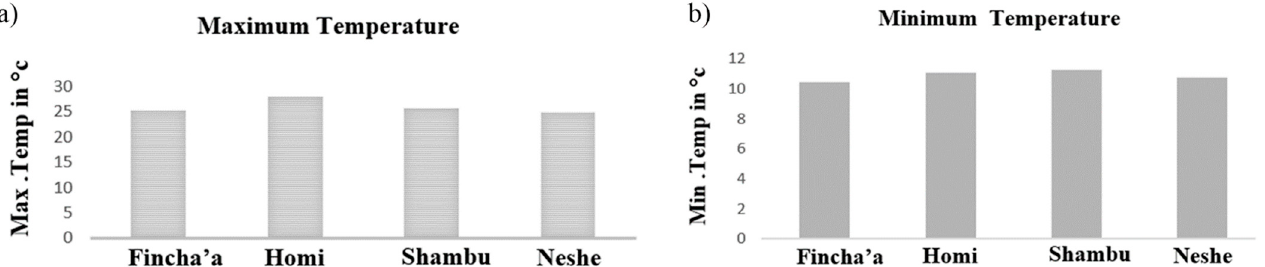
Figure 4. Yearly-averaged maximum ( a ) and minimum ( b ) temperatures measured in the four stations, during the period 1994–2018.